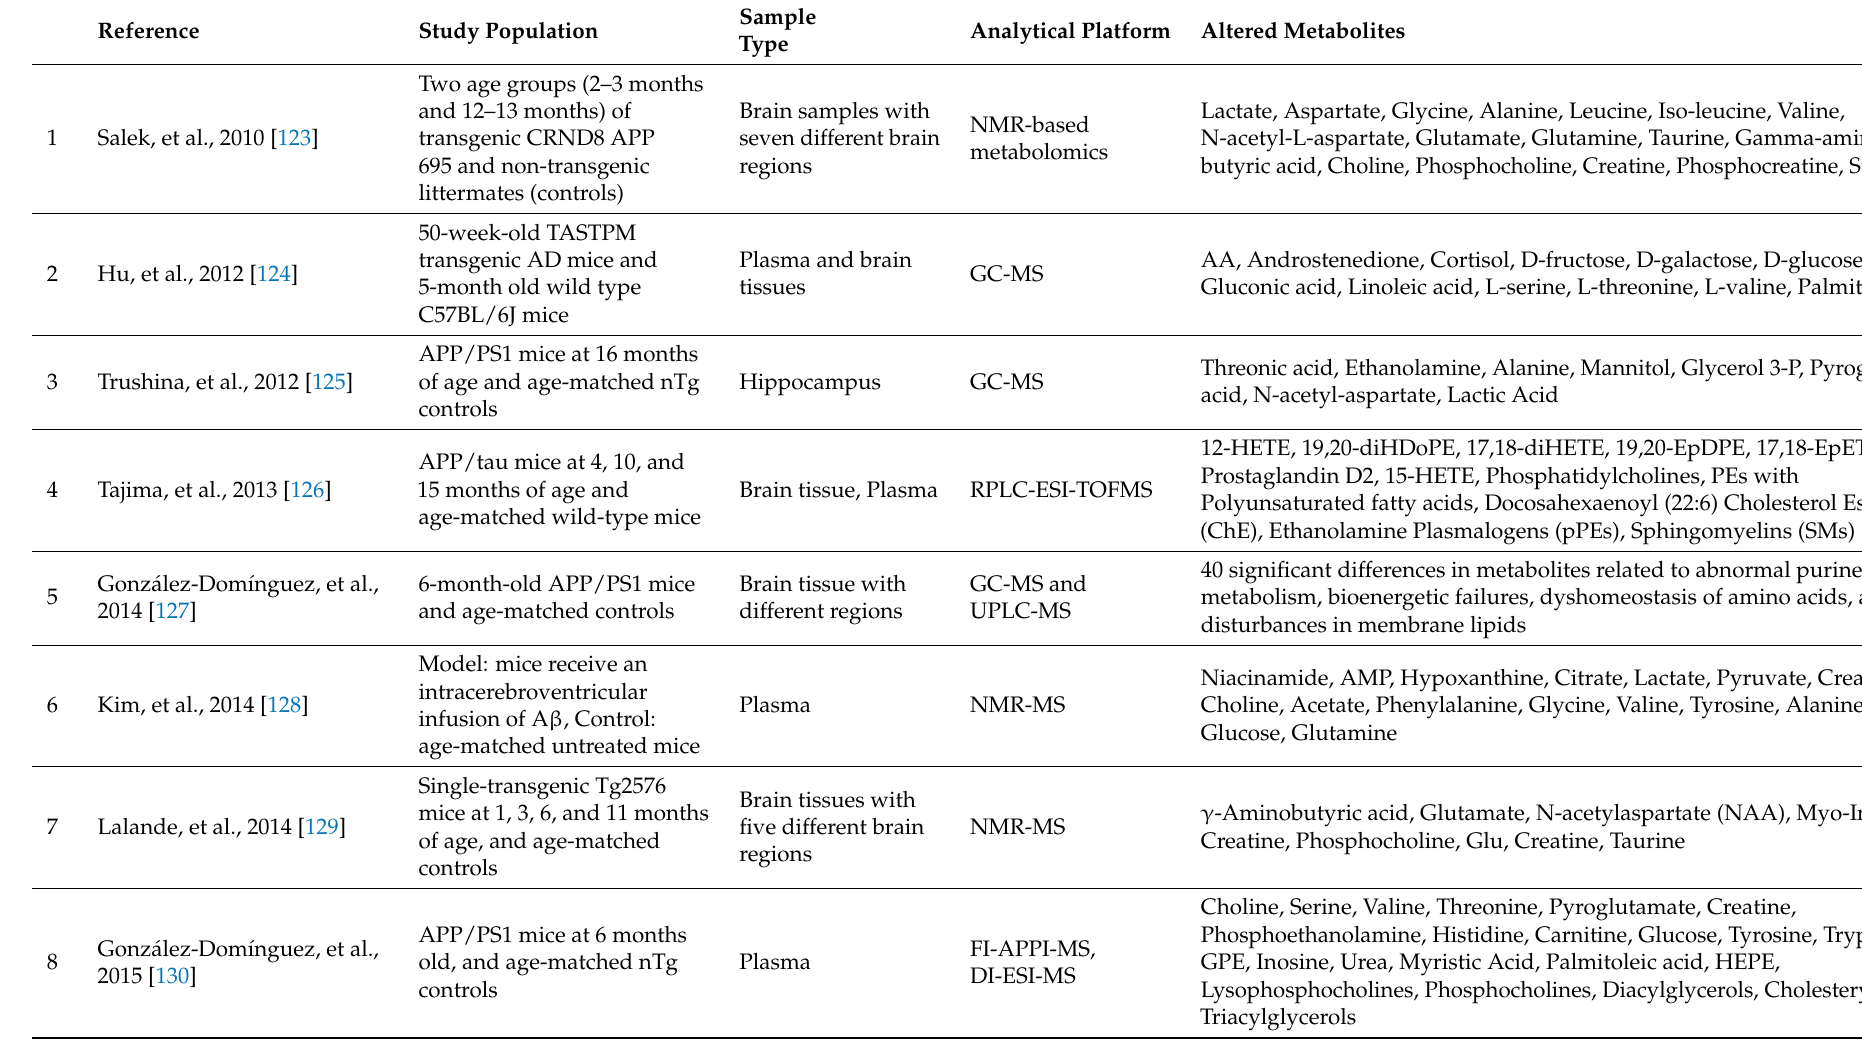
Table 2. Summary of the included articles related to metabolomics studies performed on animal